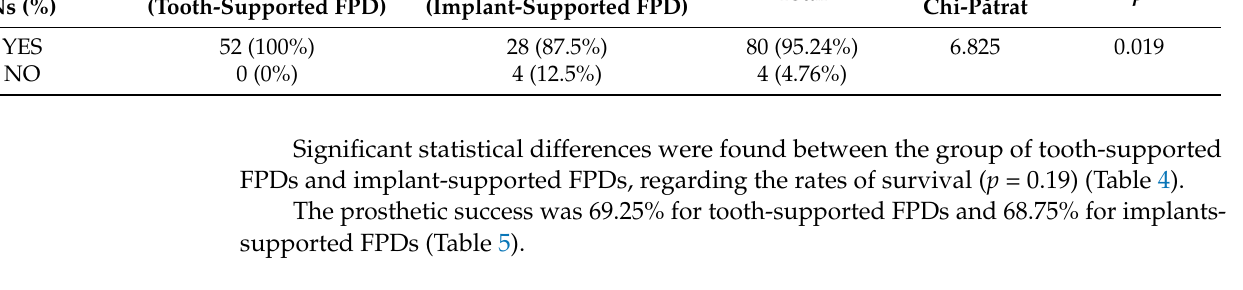
Table 5. Rate of prosthetic success (tooth-supported FPDs vs. implant-supported